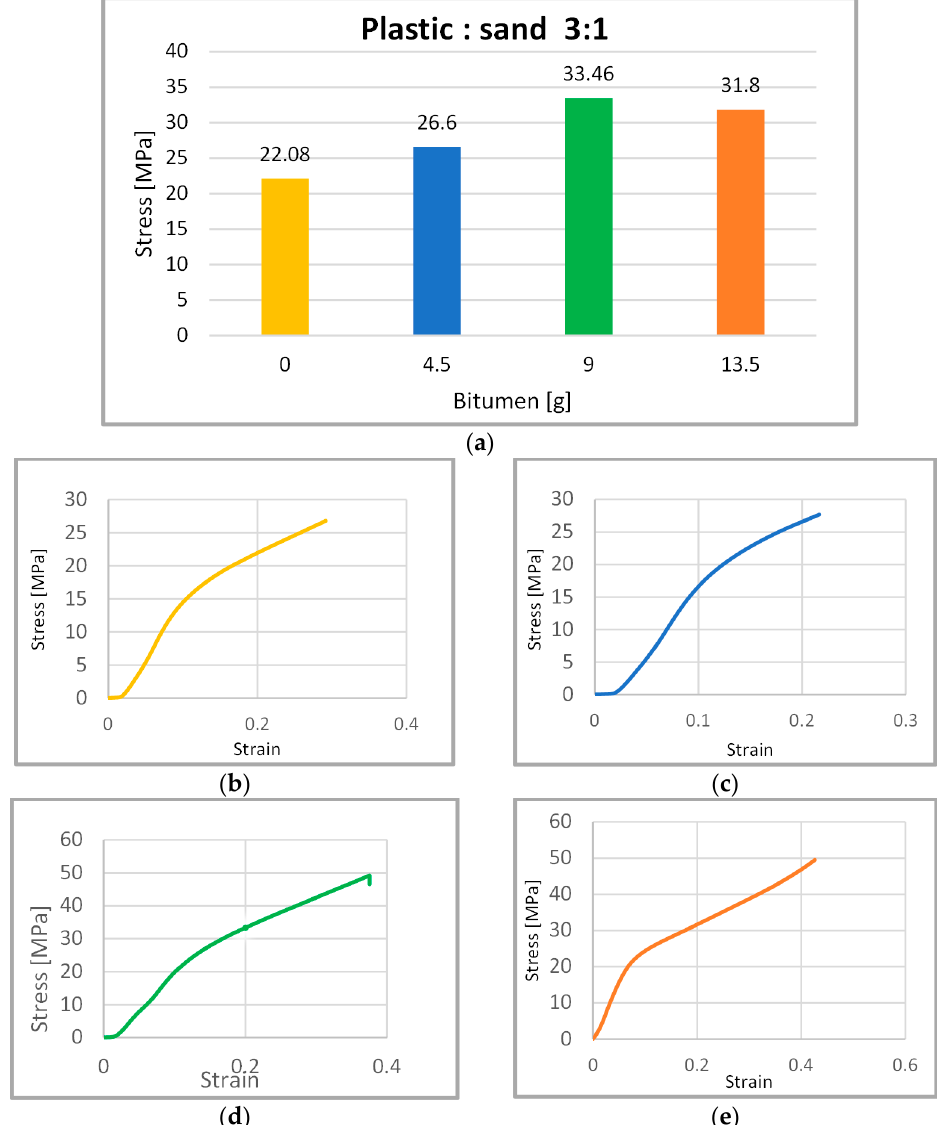
Figure 2. Results of brick sample 1. ( a ) Compression strength values of brick plastic to sand 3:1. ( b ) Stress–strain curve with 0 g bitumen. ( c ) Stress–strain curve with 4.5 g bitumen. ( d ) Stress–strain curve with 9 g bitumen. ( e ) Stress–strain curve with 13.5 g bitumen.